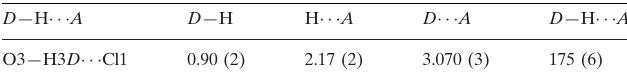
Hydrogen-bond geometry (A˚ , (cid:5)